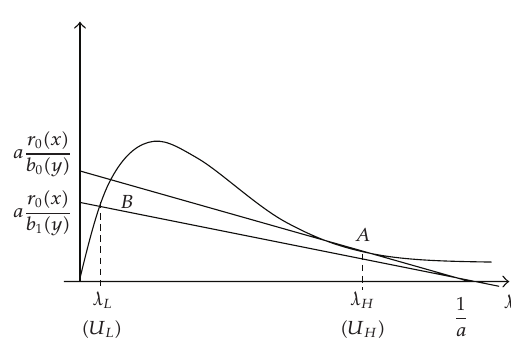
Figure 4: From high to low unemployment equilibrium.